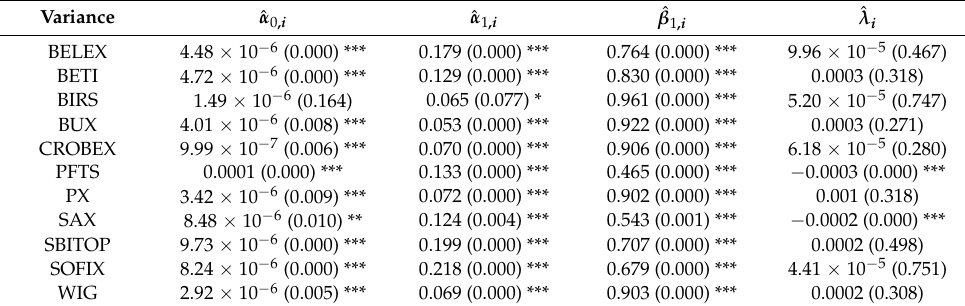
Table A2. GARCH estimation results, binary variable only day after